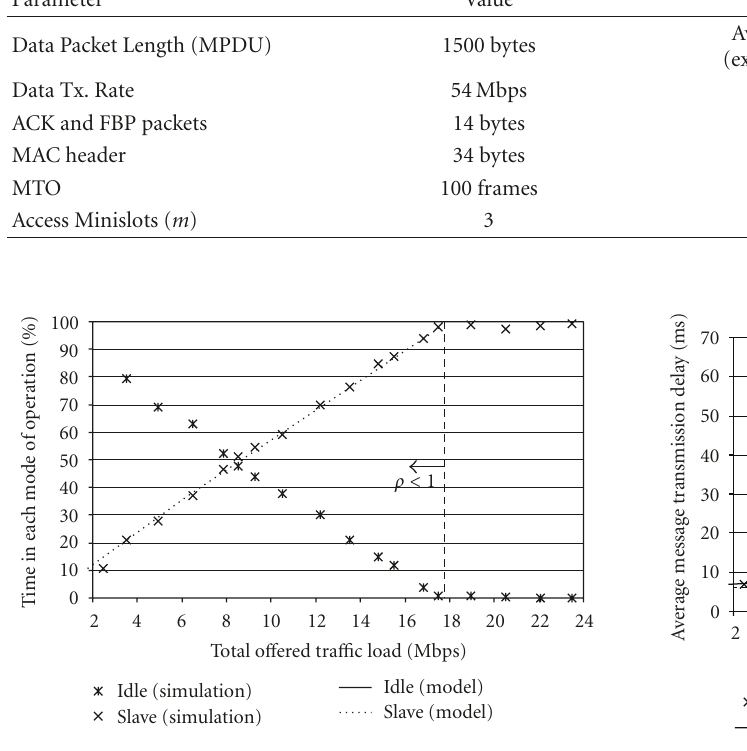
Figure 10: Percentage of Time in Idle or Slave Mode (Model versus Simulation).